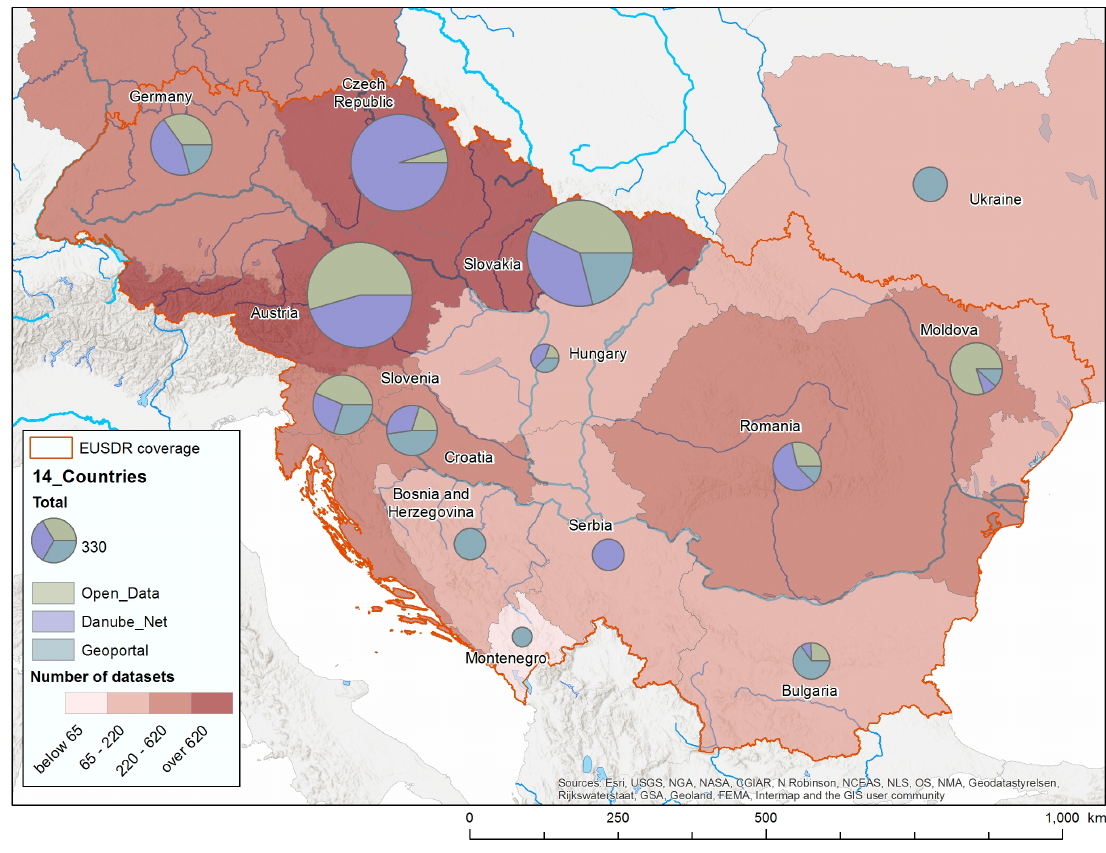
Figure 6. Data availability in the Danube region open data portal. Source: